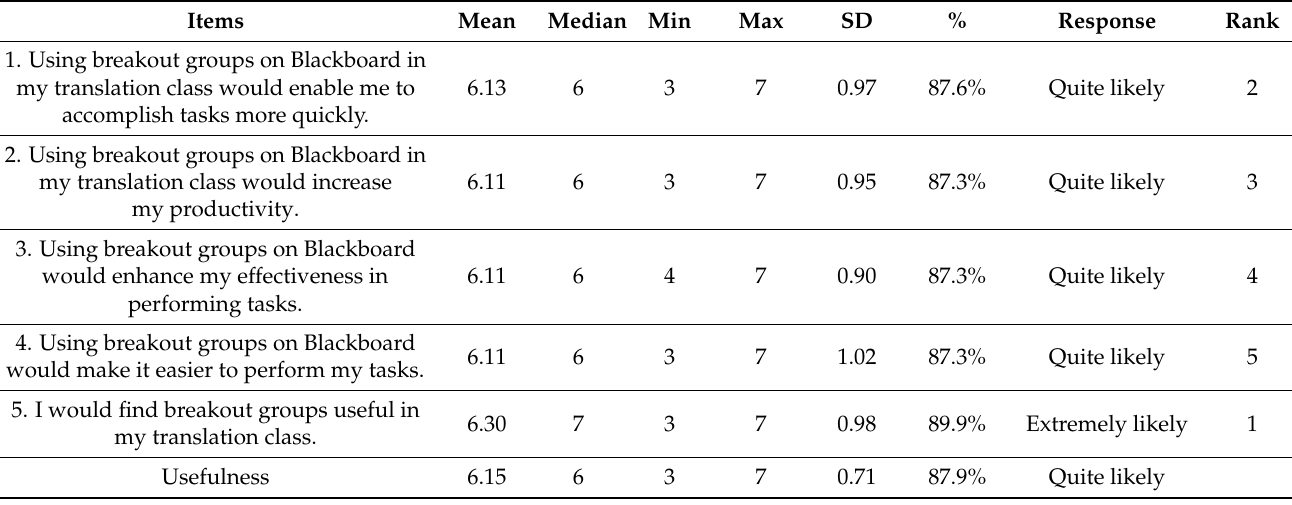
Table 7. Descriptive statistics for perceived